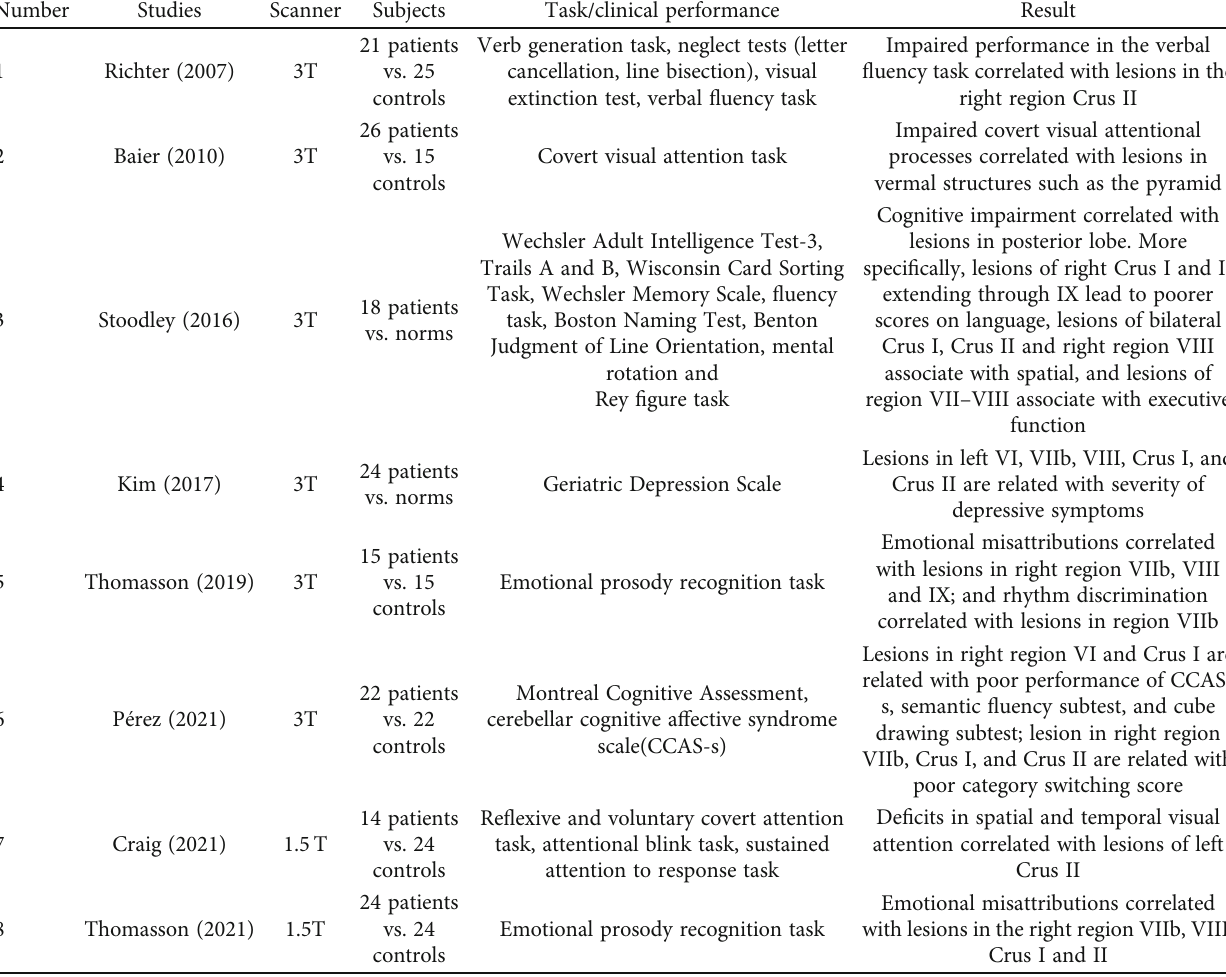
Table 1: Voxel-based lesion-symptom mapping studies of cognitive function in patients following cerebellar